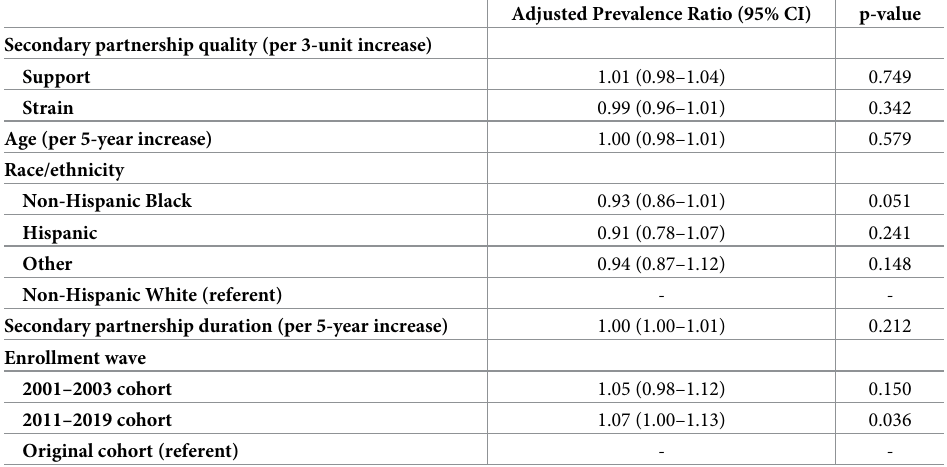
Table 5. Adjusted association of secondary partnership quality and viral load suppression among participants reporting secondary